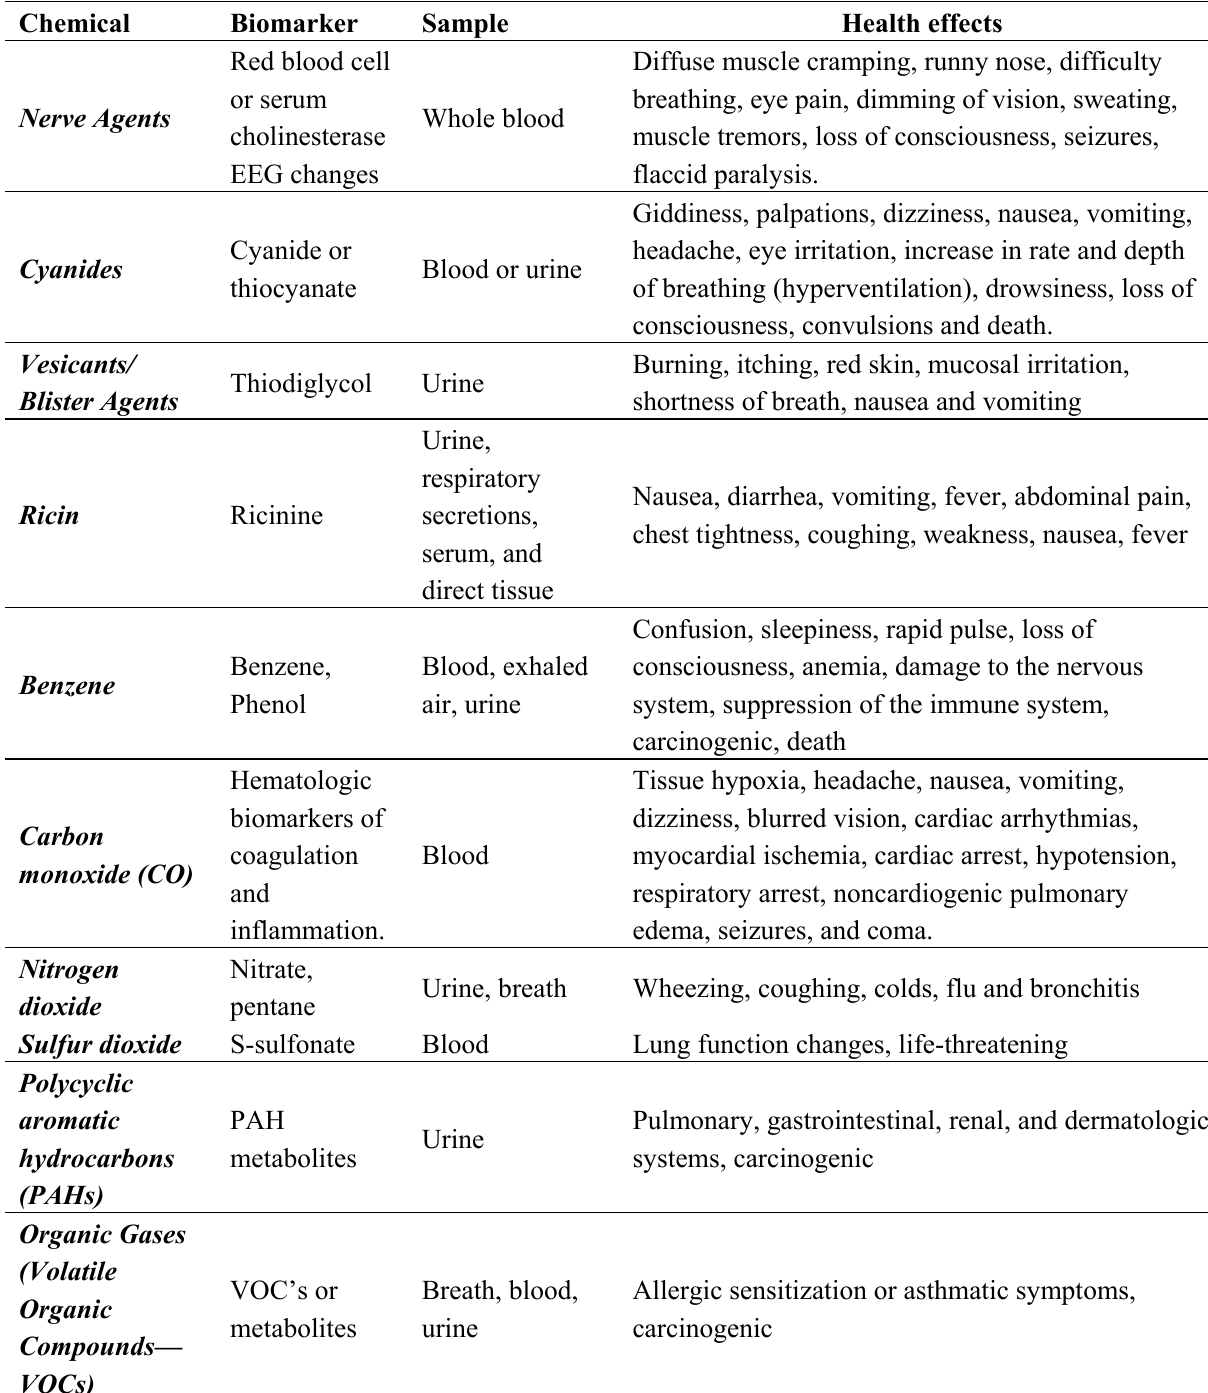
Table 1. Example of chemicals, biomarkers of exposure and health